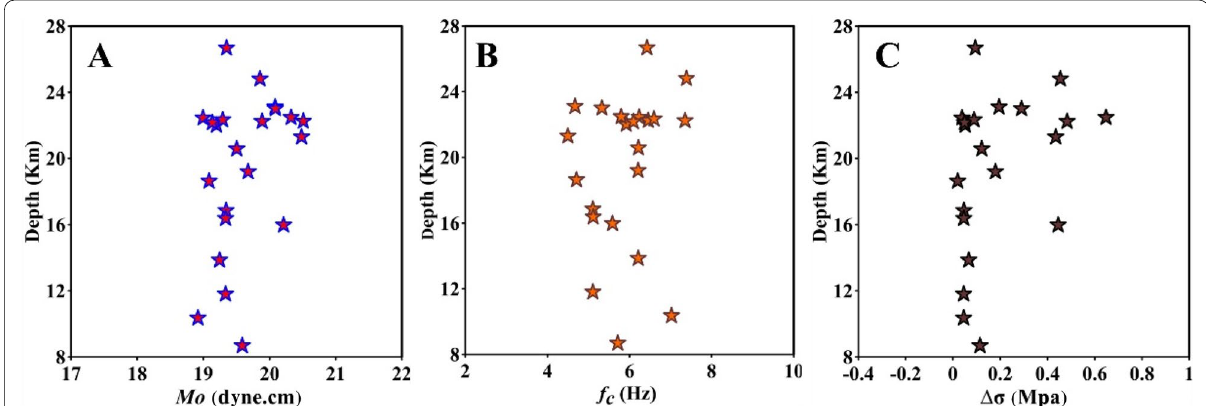
Fig. 11 The dependence of the spectral parameters such as: seismic moment ( A ), corner frequency ( B ), and stress drop ( C ) on the earthquakes depth included in this